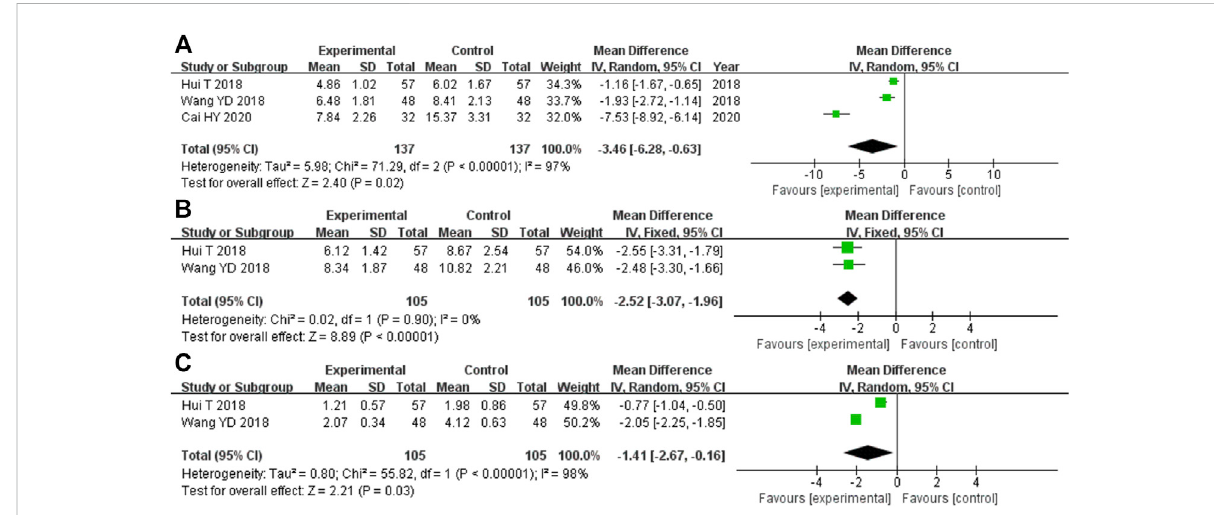
FIGURE 6 Comparativeforestplot:bloodglucose-relatedindicators. (A) ThepooledMDwas − 3.46(95%CI − 6.28to − 0.63, p =0.02).FPGwassigni fi cantly lower in the experimental cohort compared with that in the control cohort. (B) The pooled MD was − 2.52 (95% CI − 3.07 to − 1.96, p < 0.00001). FINS in the experimental cohort was signi fi cantly lower than that in the control cohort. (C) The pooled MD was − 1.41 (95% CI − 2.67 to − 0.16, p = 0.03). HOMA-IR intheexperimental cohortwas signi fi cantly lowerthan that inthecontrol cohort. MD, meandifference; CI,con fi dence interval; FPG, fasting plasma glucose; FINS, fasting serum insulin; HOMA-IR, homeostatic model assessment insulin resistance.